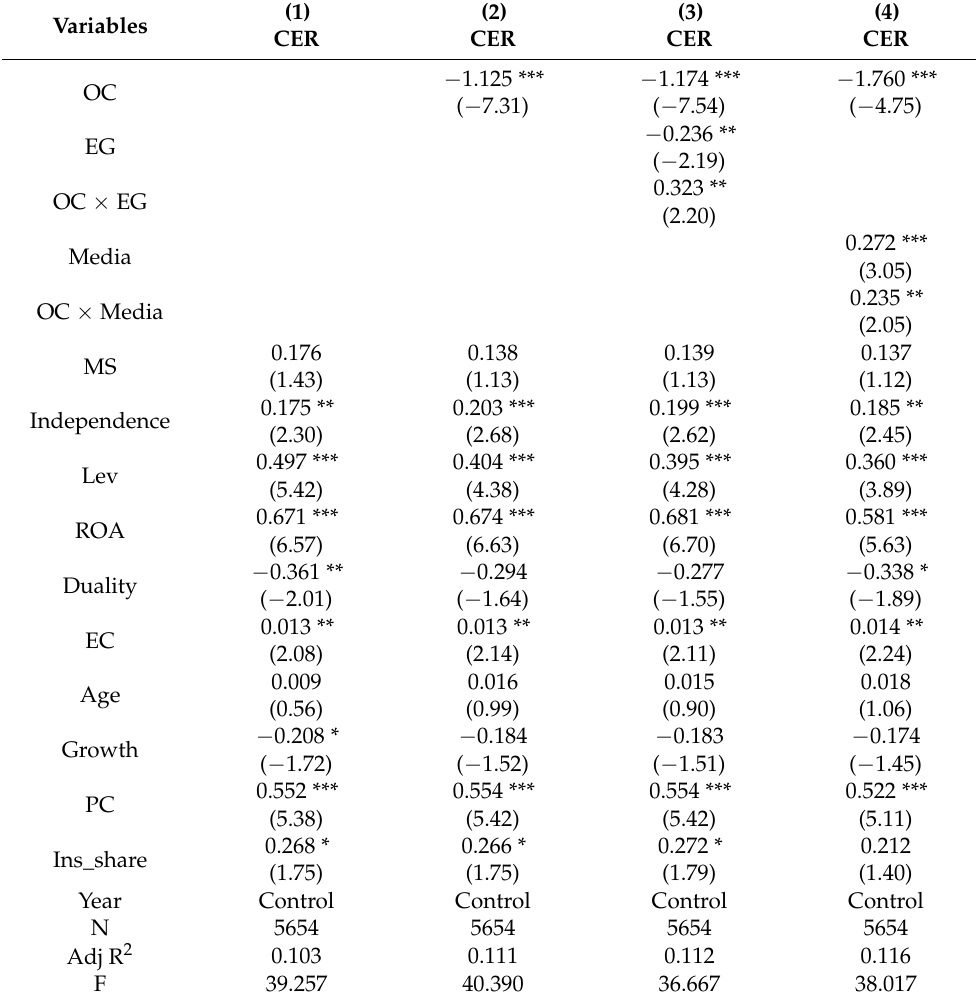
Table A3. Robustness (3)—Add Control